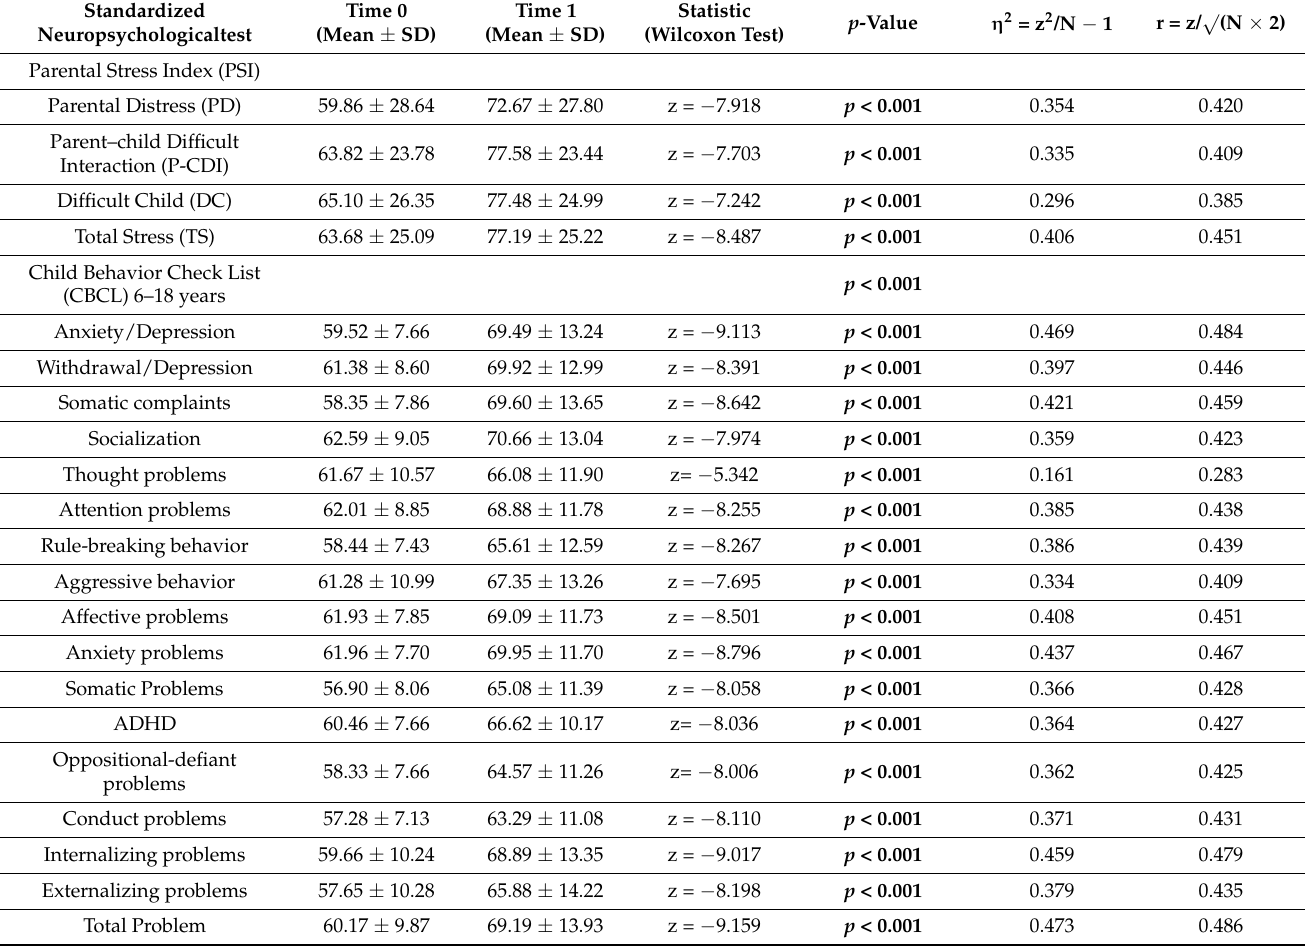
Table 3. Statistical comparison between mean scores of the Child Behavior Check List and the Parental Stress Index at time 0 (before the pandemic) and at Time 1 (March-May 2020). p -value < 0.05 are in bold. N =